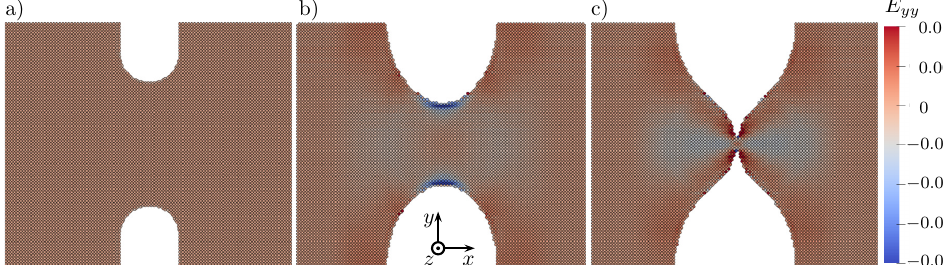
Figure 6. Discrete Green strain component ˆ E yy , evaluated by Equation (13) based on the discrete deformation gradient in Equation (21), at ( a ) the initial state, ( b ) an intermediate state and ( c ) the final state.